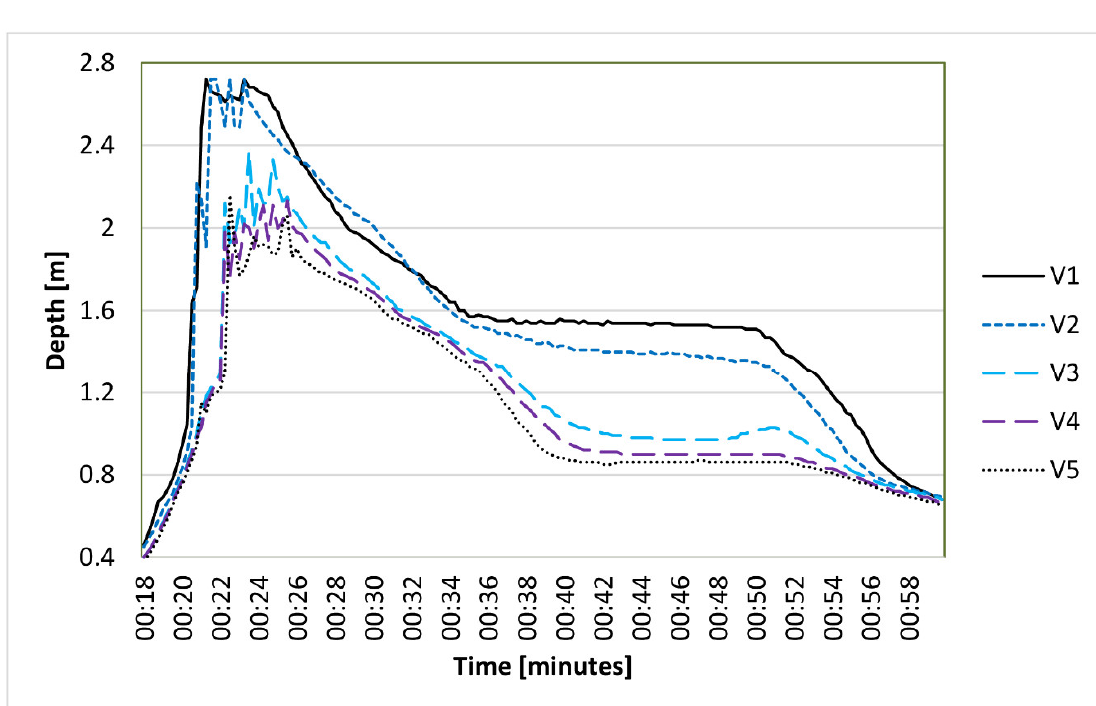
Figure 15. Depth change in Link-30 canal—F = 5 years.